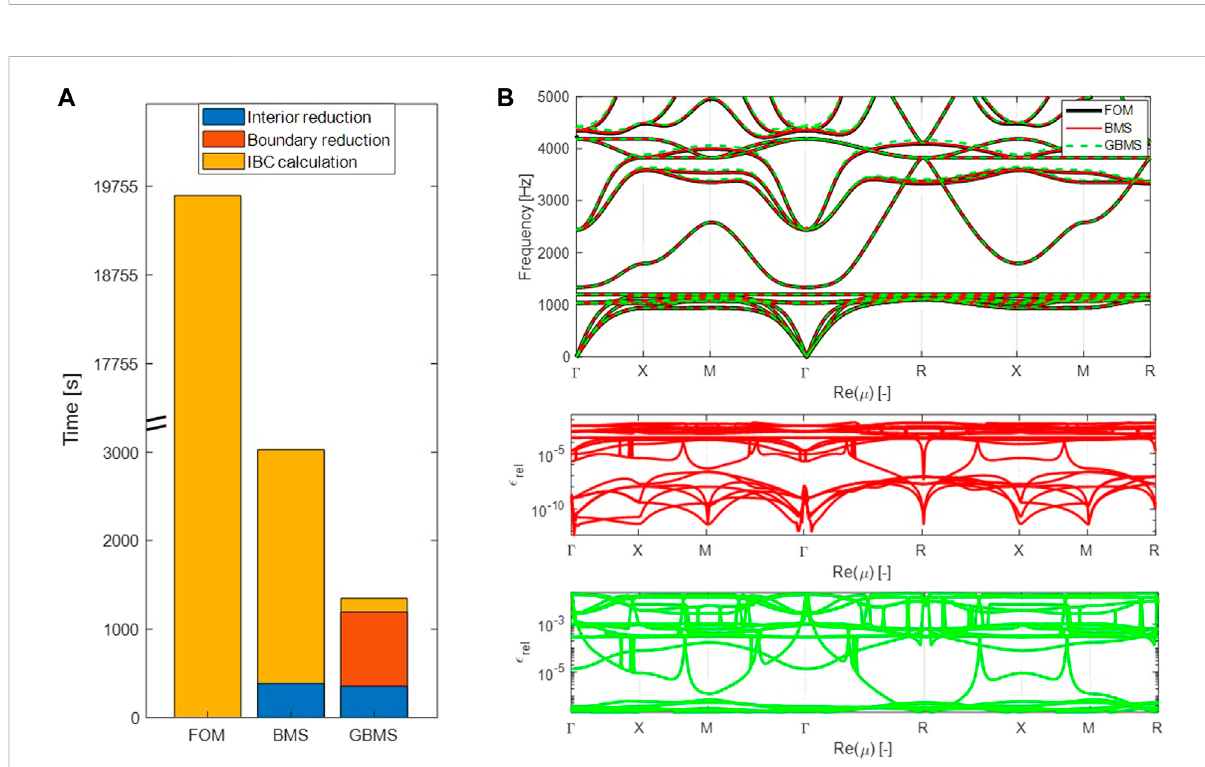
FIGURE 5 Results of the vibro-acoustic 3D periodic case. (A) Comparison of the different calculation times for the construction of the ROM and the dispersion curve calculation. (B) Dispersion curves of FOM and ROMs with corresponding relative